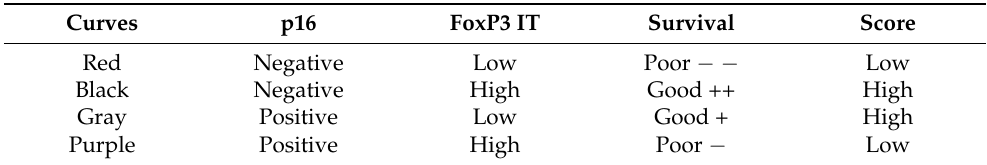
Table 5. Description of the prognostic performance of a score combining p16 status and FoxP3 infiltration in OPSCC patients.